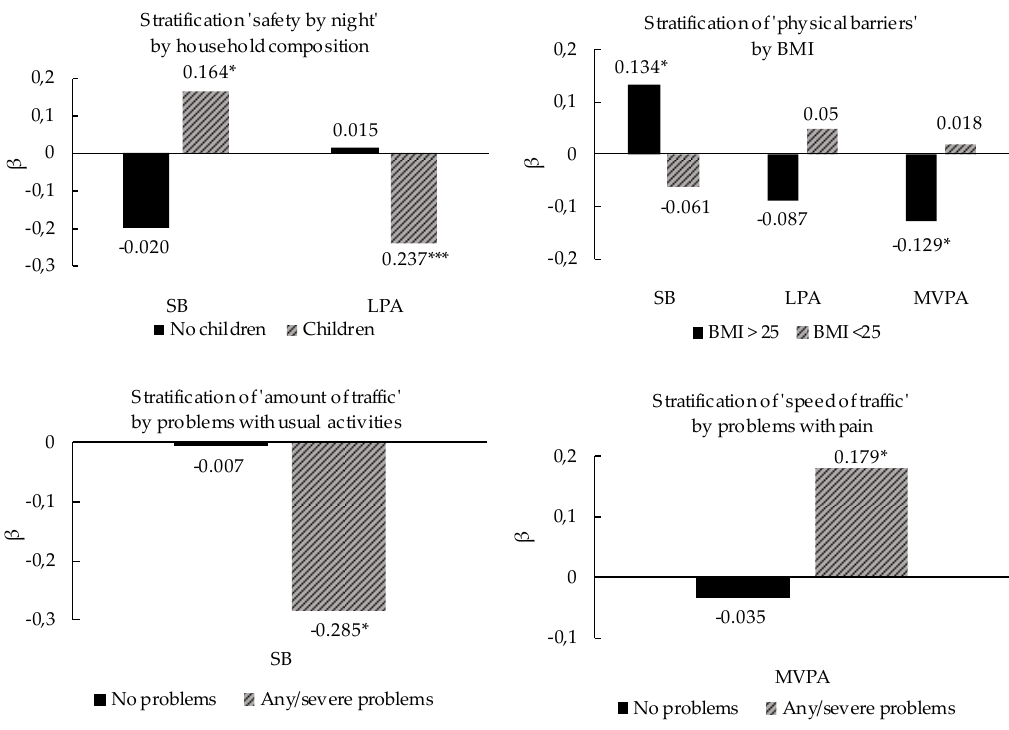
Figure 2. Interactions between personal characteristics (socio-demographic and HRQoL) and PA-hindering built environmental characteristics. * = p < 0.05; *** = p < 0.001.